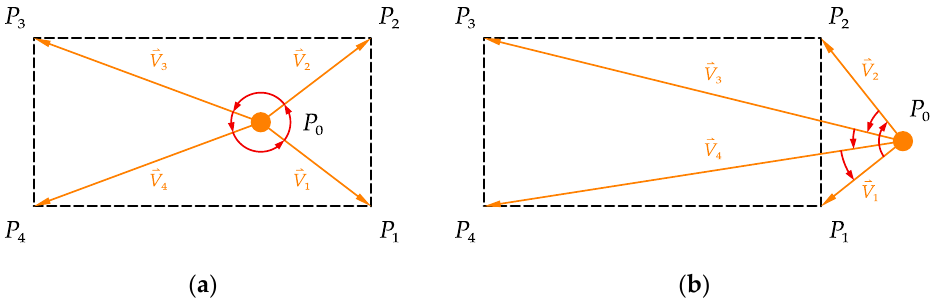
is on the plane 𝑃𝑃 0